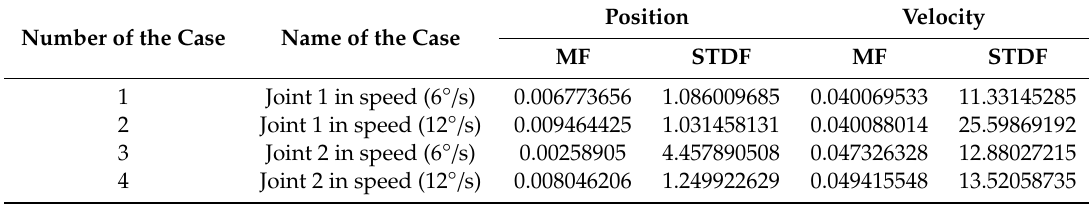
Table 8. Mean Frequency (MF) and Standard Deviation frequency (STDF) for both position and velocity for the reconstructed residual by the SSAHT technique. (Unit: ◦